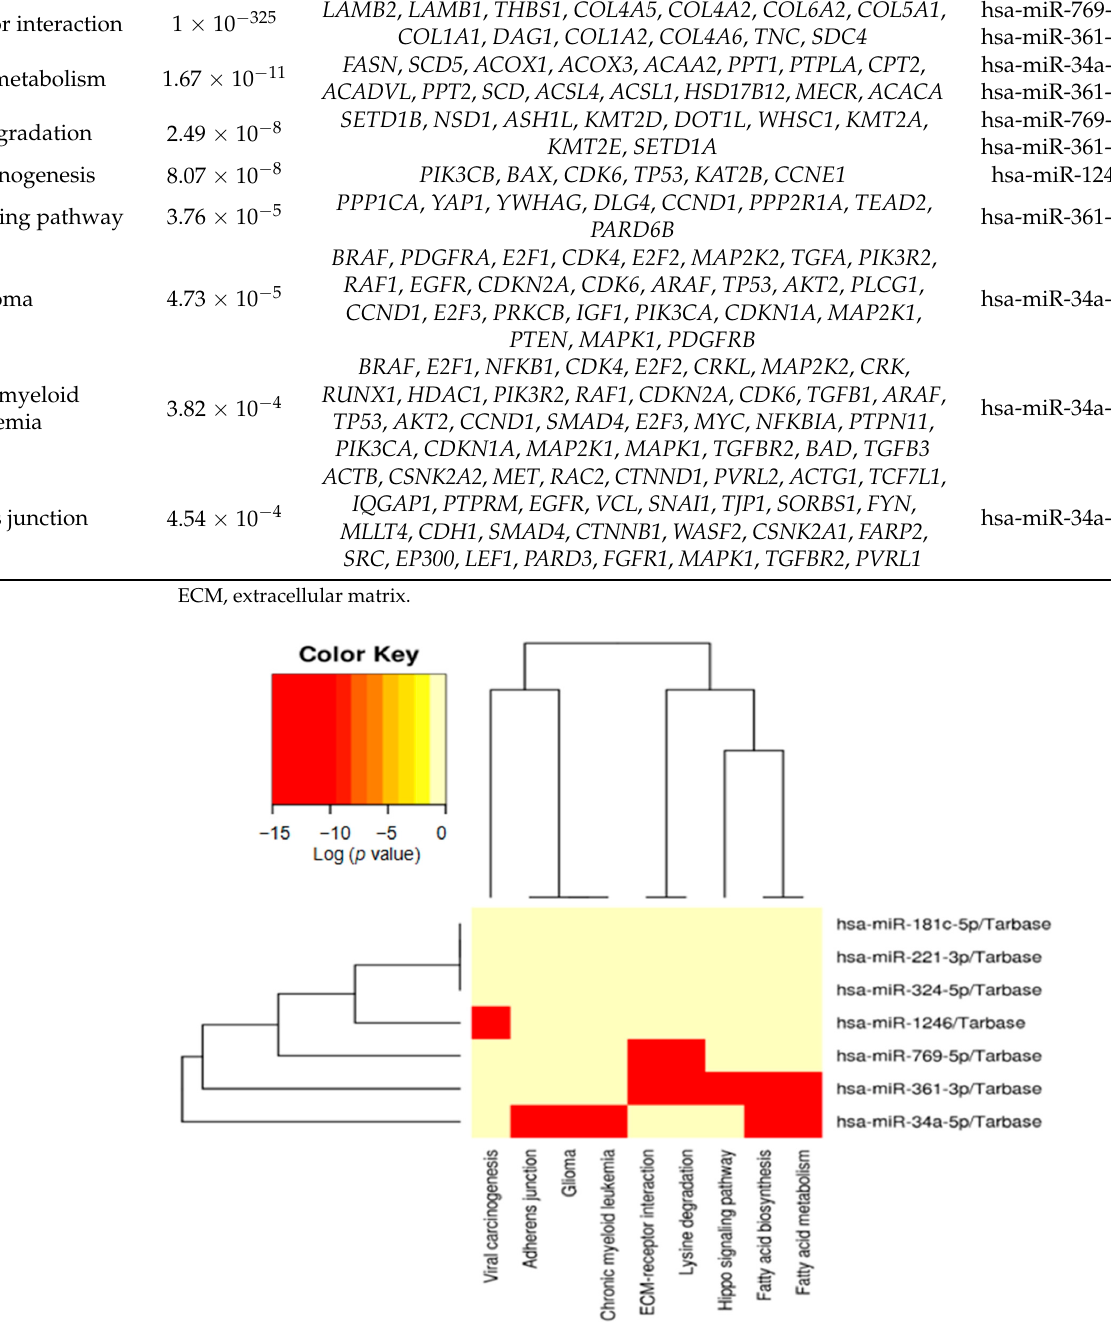
Figure 2. KEGG pathway heatmaps reveal that miRNAs are significantly differentially expressed in FBXW7 -mutated rectal neuroendocrine tumors.